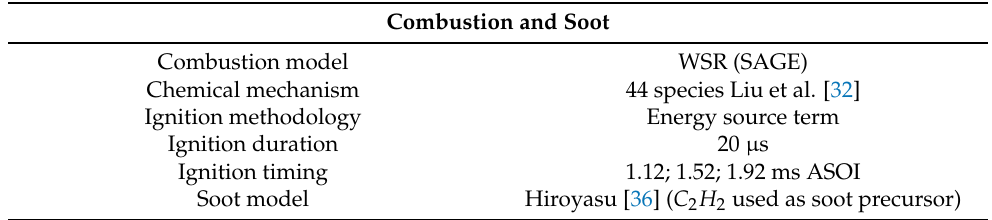
Table 4. Combustion and soot